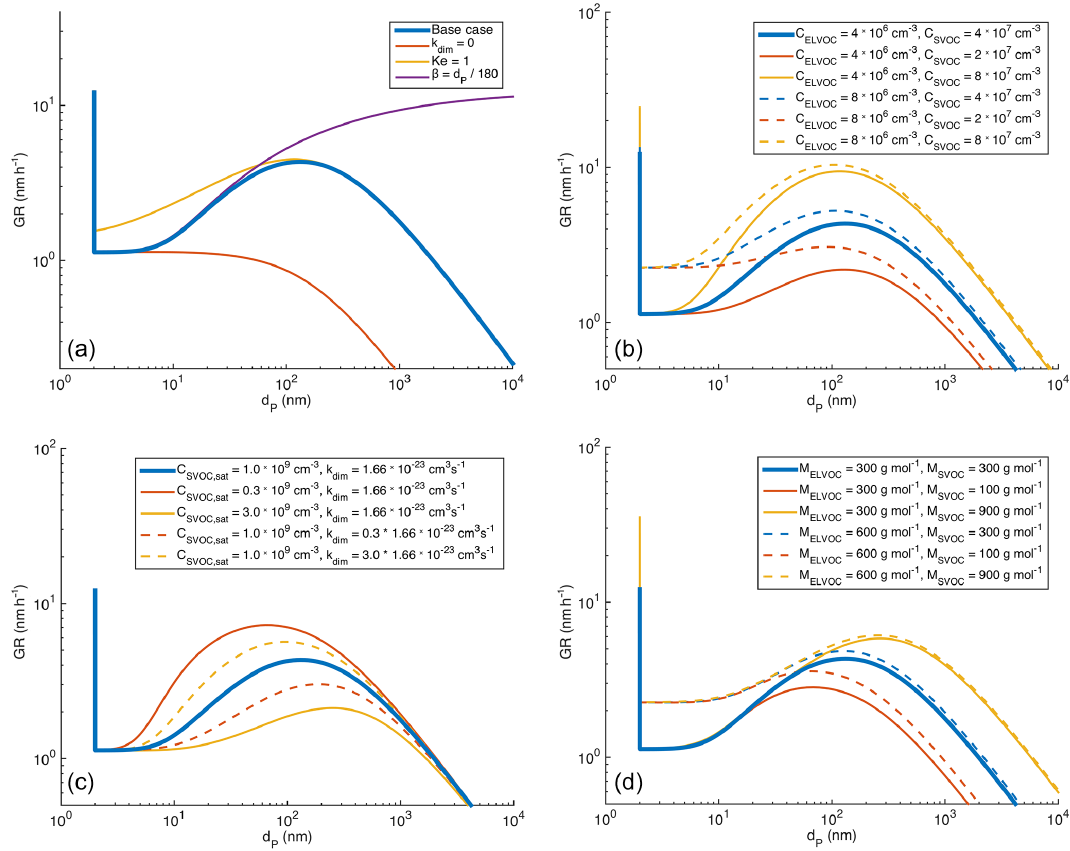
Figure 11. Modelled growth rate of an aerosol particle with indication of factors causing the changes in GR as a function of diameter (panel a ) and sensitivity analysis towards indicated factors (panels b–d ). More details in